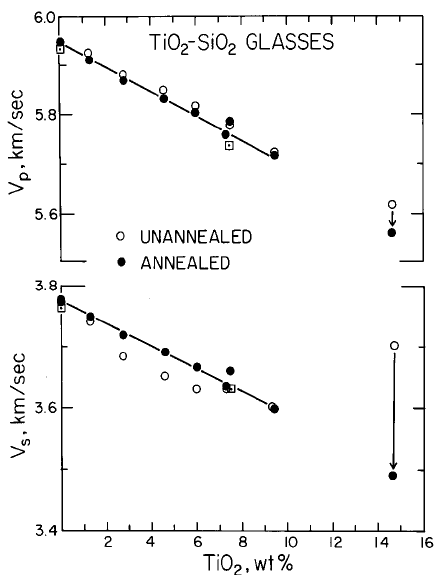
Figure 1. Longitudinal ( V p ) and shear wave ( V s ) velocities versus TiO 2 content for unannealed (as received) and annealed glasses. For the compositions up to 9.4 wt% TiO 2 , annealing causes an increase in V s and a slight decrease in V p . Squares are McSkimin’s (unpublished) 1972 data for the CorningULE ® 7971 glass. For the 14.7 wt% glass, which is partly crystalline, both velocities drastically decrease on annealing (see text for discussion).